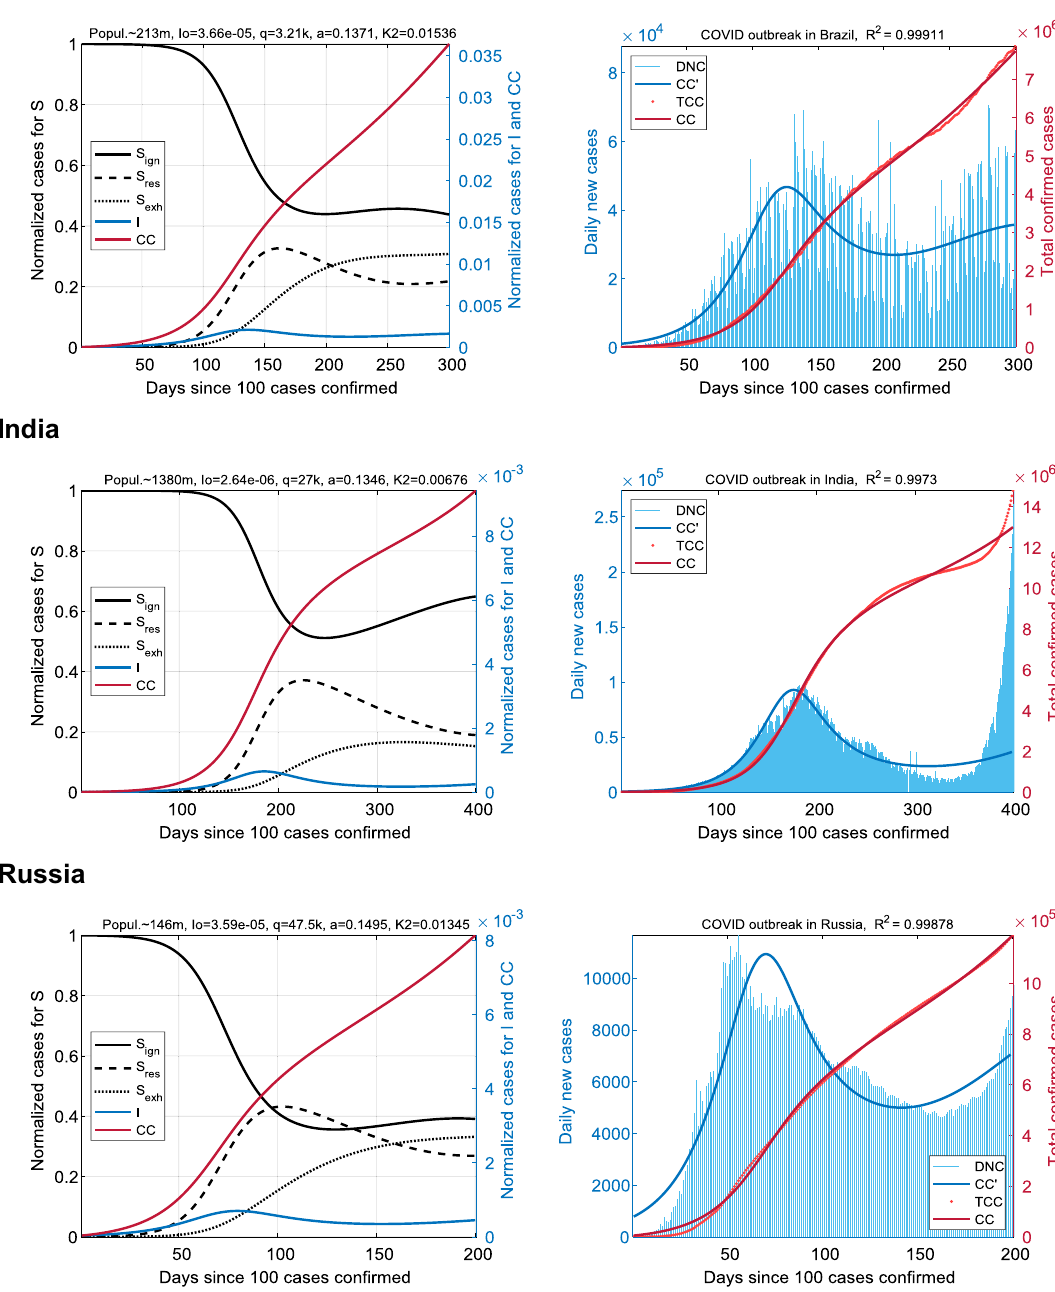
Figure 4. Coronavirus outbreaks in countries with a low resistance index. Results for Brazil (top panel), India (center), and Russia (bottom). Trajectories are characterized by a low S res and a high S ign in comparison with the previous groups. The exhausted fraction of the population S exh , on the contrary, is quantitatively comparable and evolves in approximately the same scenario. The end of the first wave I(t) smoothly turns into the second one. To simulate the spread of COVID-19 in Brazil and India, which have large populations, intervals of 300 and 400 days were taken,